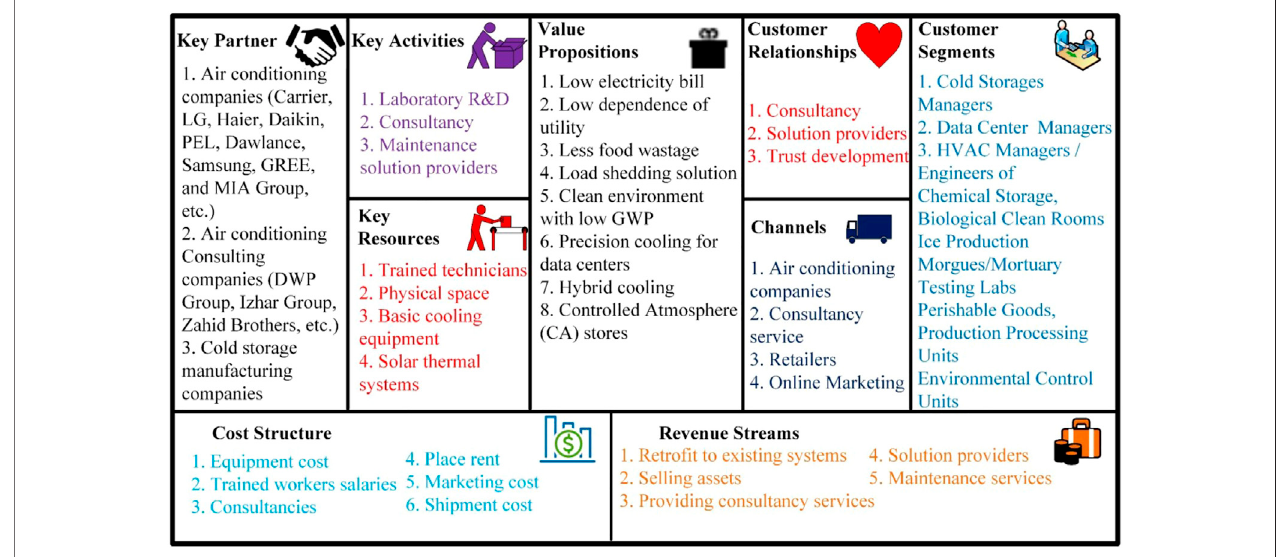
FIGURE 13 | Updated BMC describing the feasibility, desirability, and viability of solar thermal cooling adapted from Osterwalder and Pigneur (2010), Van Der Pijl et al. (2016a).